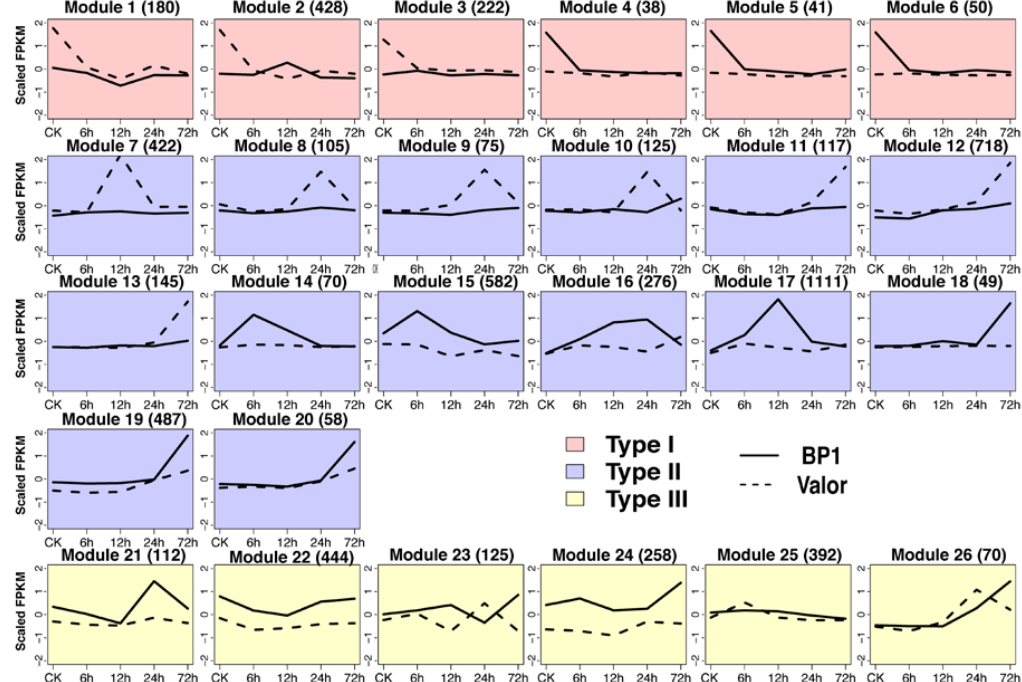
Figure 4. Changes in the expressions of the protein-coding genes, circRNAs and long intergenic noncoding RNAs (lincRNAs) within the modules over the stage of infections in two cultivars (dashed line, Valor; solid line, BP1). The different background colors represent for different module types divided by expression